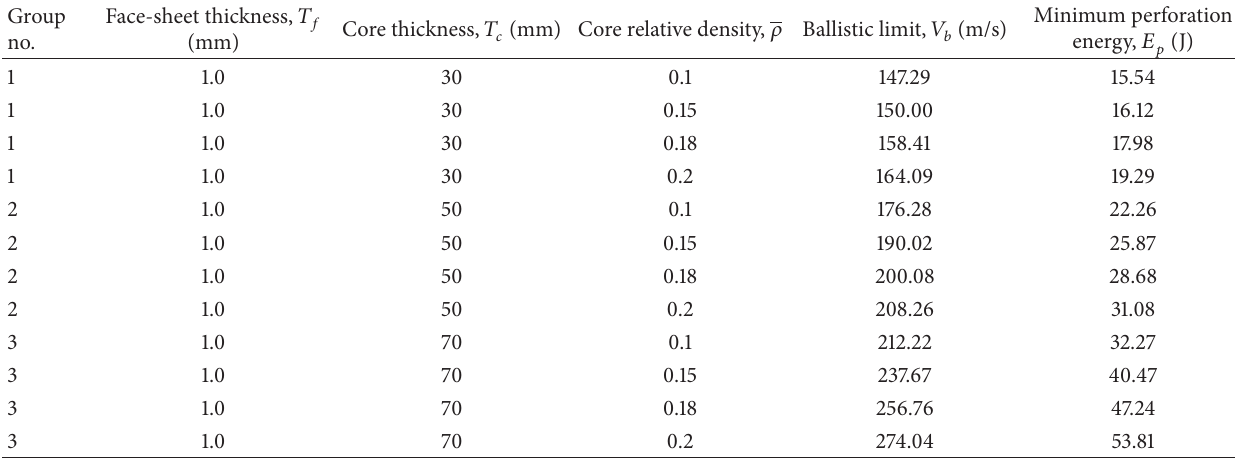
Table 3: Specifications and numerical results of three groups of auxetic HSPs, each of which has identical core thickness ( 𝑇 𝑐 = 30mm, 50mm and 70mm, respectively) and face-sheet thickness ( 𝑇 𝑓 = 1.0mm), but different core relative densities ( 𝜌 = 0.1, 0.15, 0.18 and 0.2, respectively), so that the effect of core thickness and relative density can be